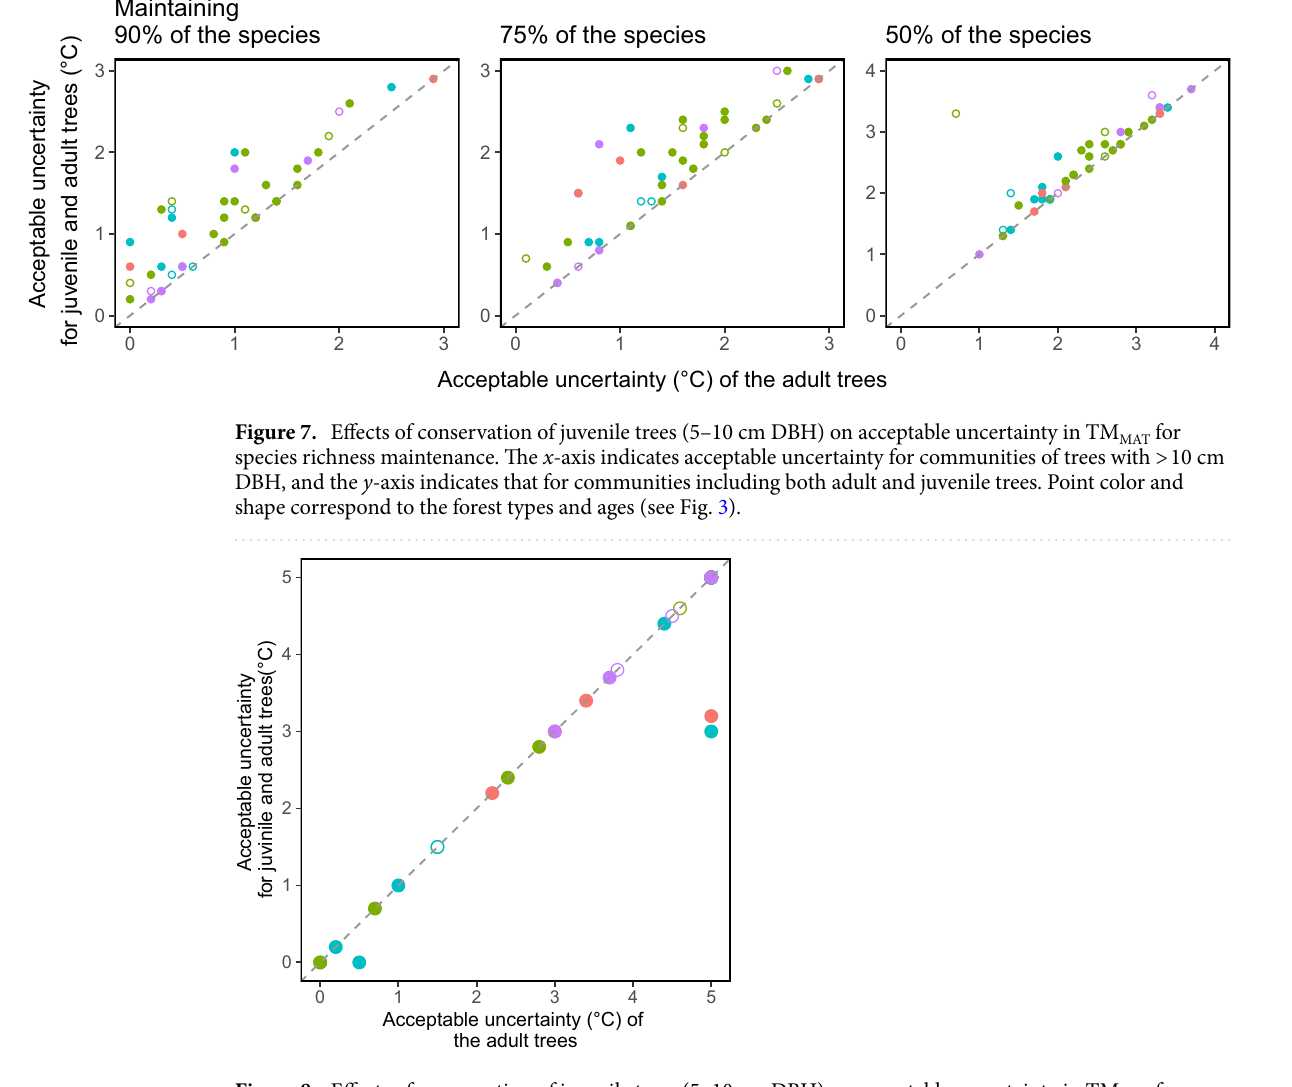
Figure 8. Effects of conservation of juvenile trees (5–10 cm DBH) on acceptable uncertainty in TM MAT for forest type maintenance. The x -axis indicates acceptable uncertainty for communities of trees with > 10 cm DBH, and the y -axis indicates that for communities including both adult and juvenile trees. Point color and shape indicate functional type and forest age of the adult tree layer at the current stage (see Fig.